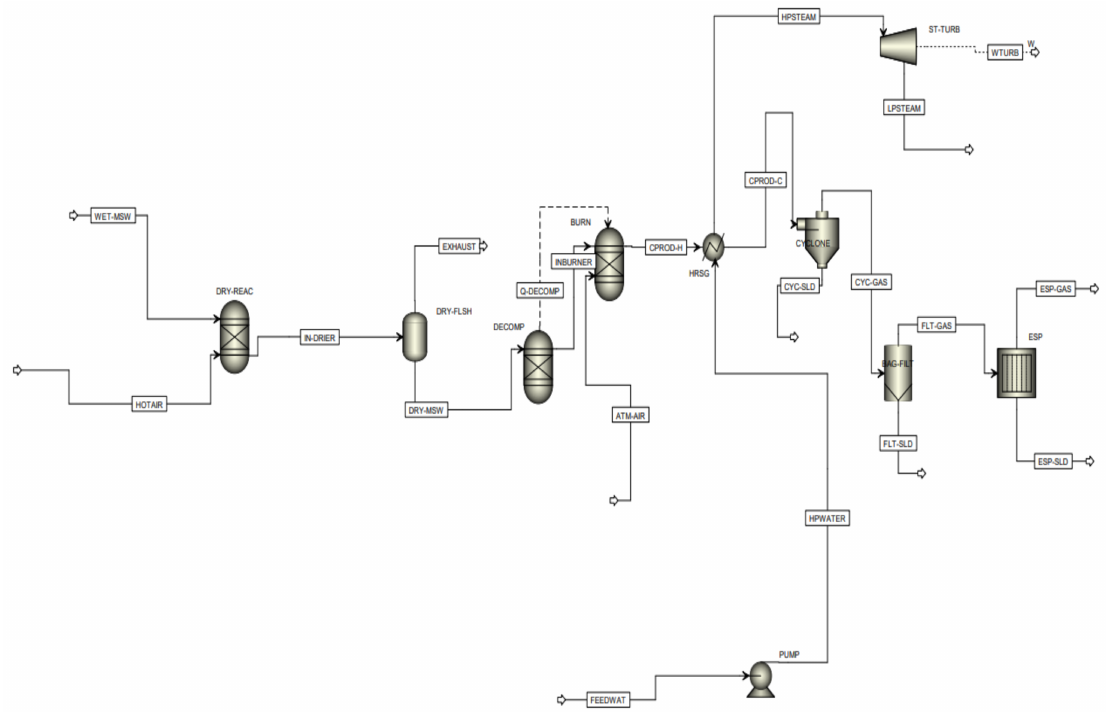
Figure 3. Waste Incineration Aspen Plus ® model flowsheet [27].